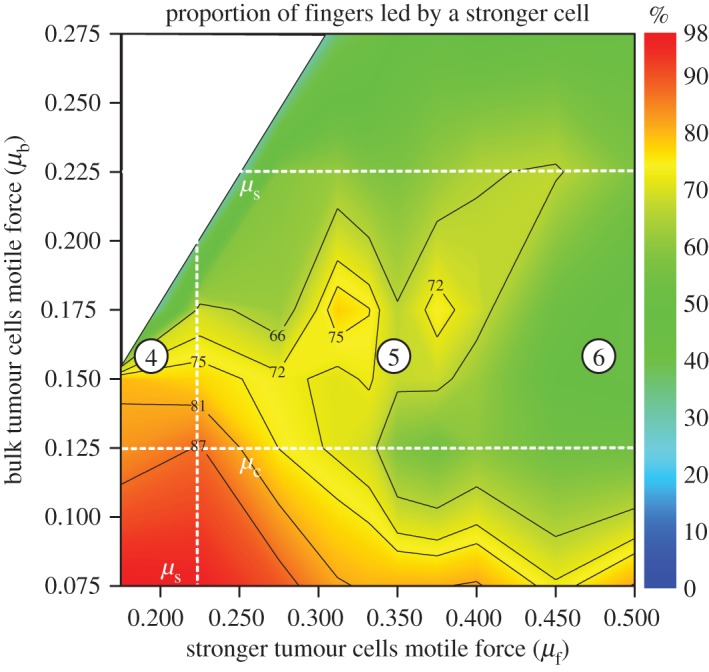
Morphology of invading structures in heterogeneous tumours. Heat map of the proportion of fingers led by a stronger cell. Details on the computation of this quantity from in silico experiments data are provided in the electronic supplementary material. The dataset presented is the same as for figure 2b.